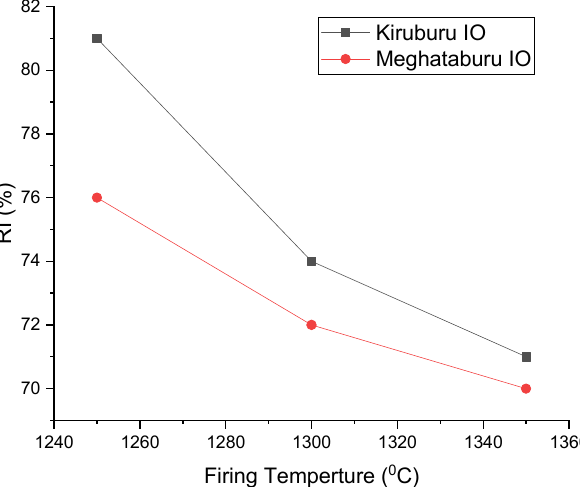
Figure 18. Effect of Firing Temp. on R.I.